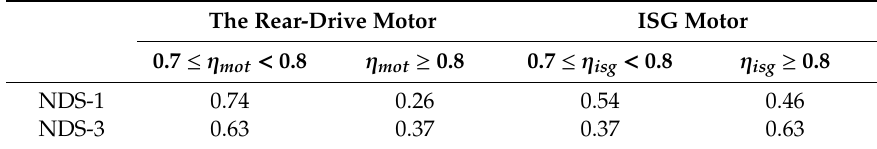
Figure 12. The optimal solutions. ( a ) The three-dimensional Pareto solution set; ( b ) the term Pareto front graph between the acceleration time and electric energy consumption and ( c ) the term Pareto front graph between the acceleration time and fuel economy. Table 3. Comparison of the rear-drive motor and ISG motor’s e ffi ciencies between NDS-1 and